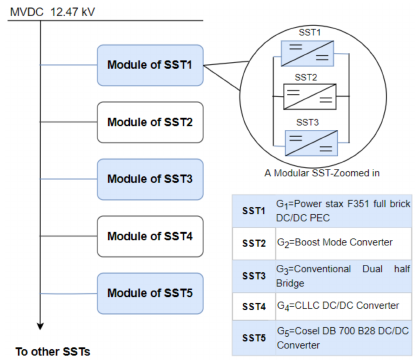
Figure 4. DC distribution system with modular structure zoomed